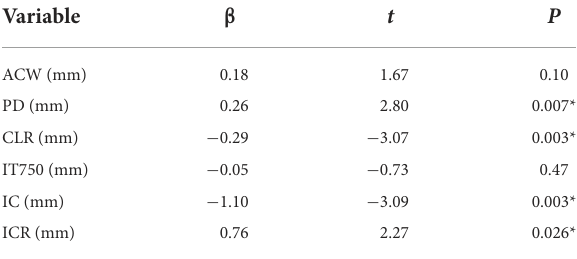
TABLE 2 Results of multiple linear regression analysis evaluating the correlation between preoperative parameters and postoperative vault ( n =